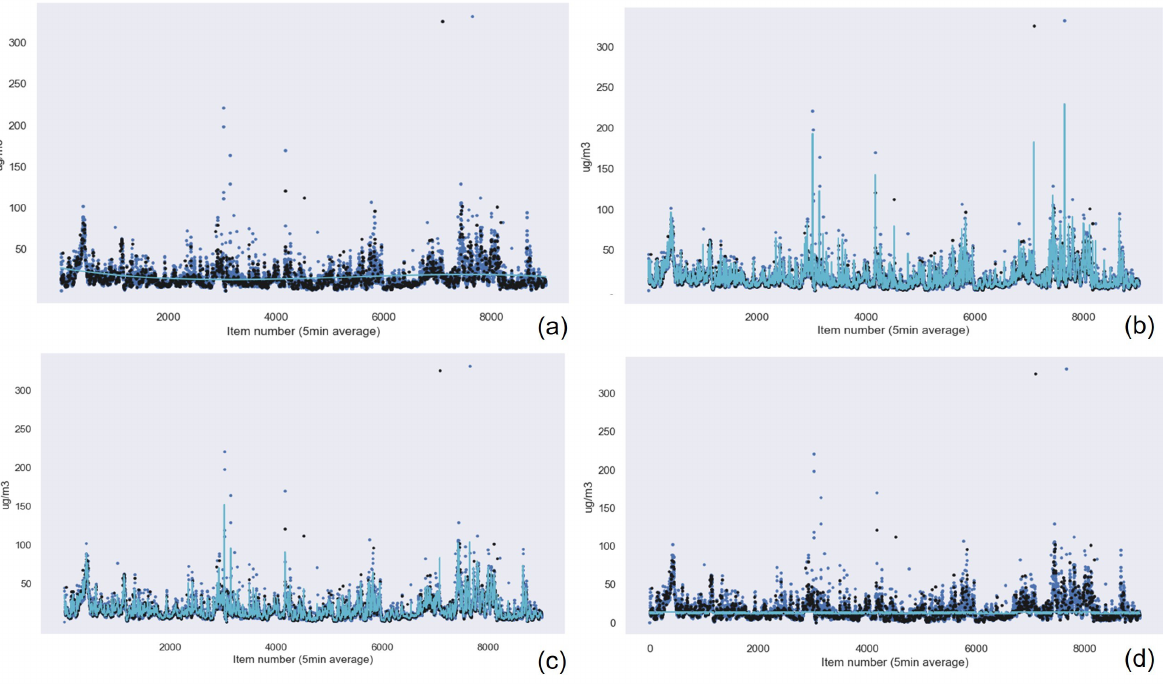
Figure A17. Cont